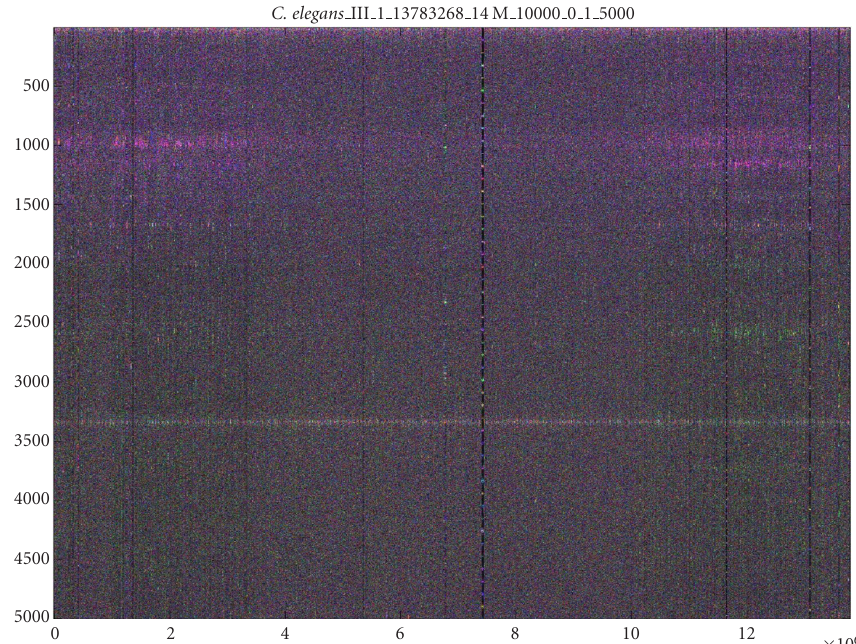
Figure 4: Spectrogram of the chromosome III of C. elegans (13.8Mbp). The 3-base periodicity relating to protein coding is noted. A mini- satellite is noticeable at 7.4 Mbp (see Figure 16). Various periodicities are noticeable, in particular, the purple 10+-base periodicity in both chromosome arms and coincident 8,9-base and green 3.8-base periodicities in the right chromosome arms.